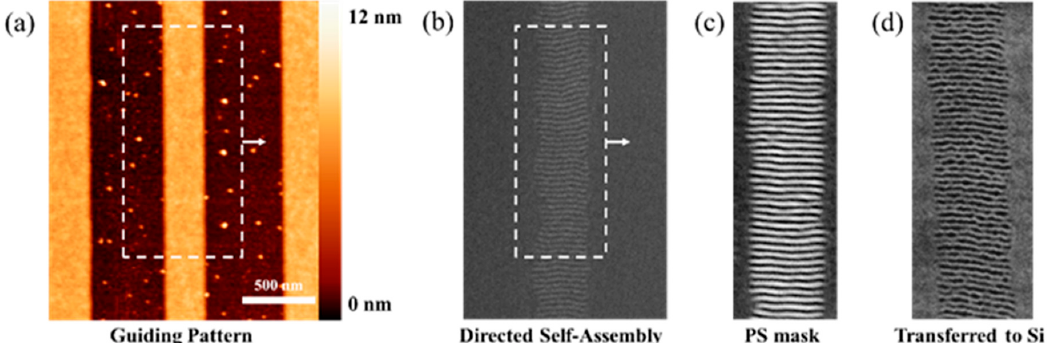
Figure 4. Micrographs of di ff erent fabrication stages in the pattern transfer process. ( a ) AFM image of m-AFM treated area for grain-boundary-induced alignment; ( b ) DSA of block copolymers on the presented guiding pattern, while the excerpt corresponds to area surrounded by dashed line in ( a ); ( c ) PS etch mask after selective removal of PMMA via Reactive Ion Etching (RIE) (area corresponds to white dashed line in ( b )); ( d ) pattern transferred into silicon.